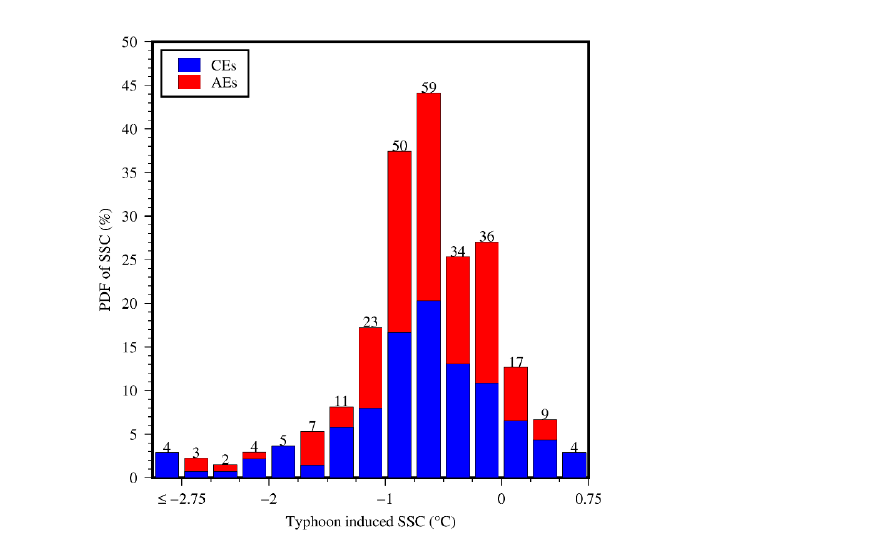
Figure 6. The probability density function of typhoon-induced sea surface cooling in the CEs (blue) and AEs (red). The width of the bins is 0.25 °C, and the corresponding number is labeled at the top of each bar. and AEs (red). The width of the bins is 0.25 ◦ C, and the corresponding number is labeled at the top of each bar.